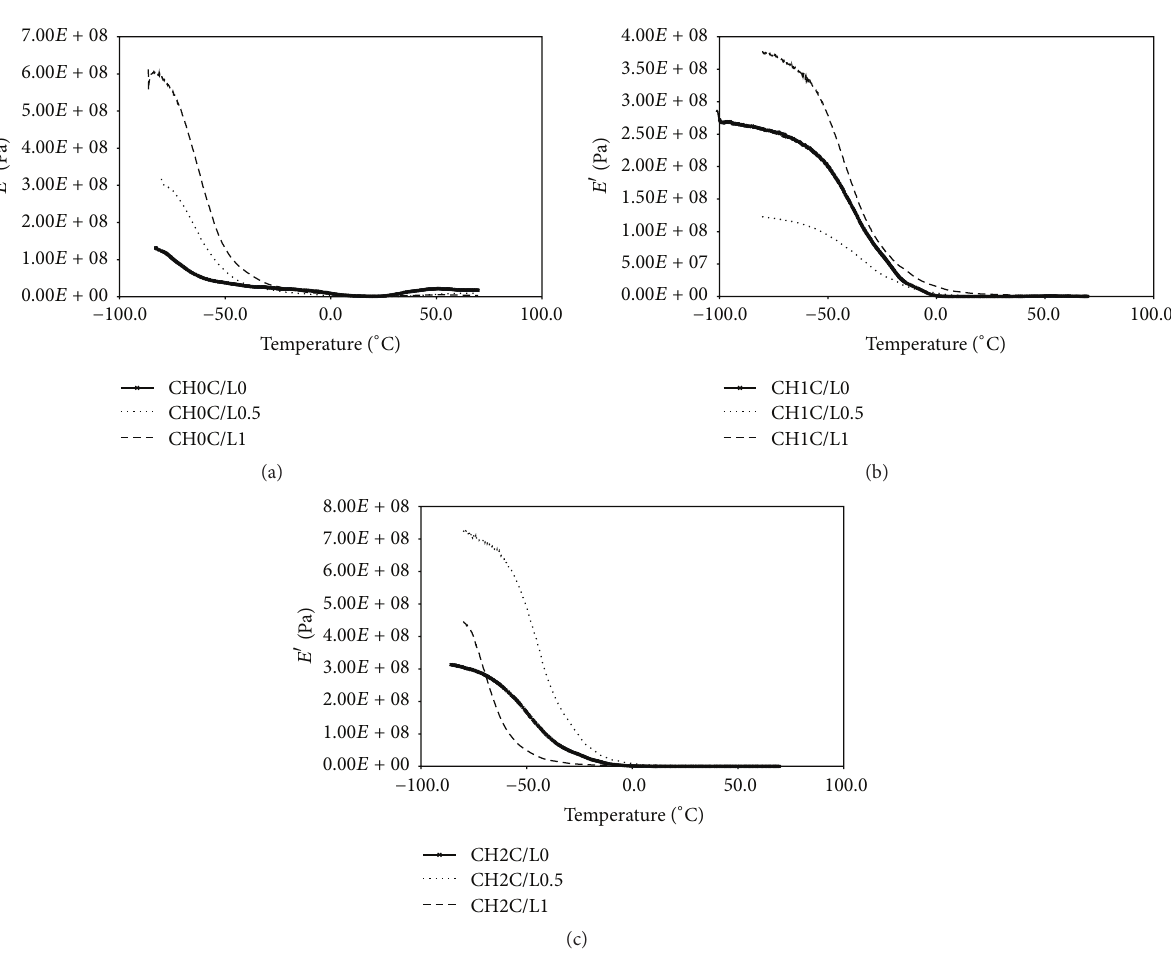
Figure 1: Storage modulus ( 𝐸 󸀠 ) of HMPC, CH, and C/L preparation films of (a) CH0C/L0, CH0C/L0.5, and CH0C/L1; (b) CH1C/L0, CH1C/L0.5, and CH1C/L1; and (c) CH2C/L0, CH2C/L0.5, and CH2C/L1